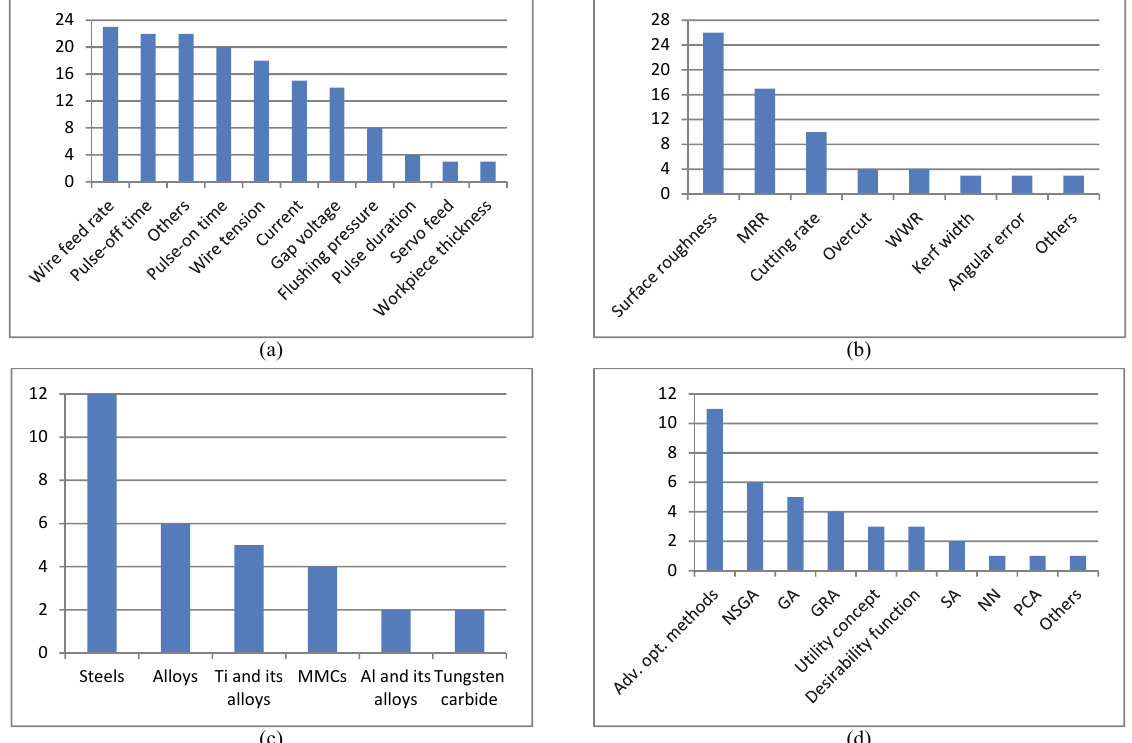
Fig. 3 Analysis on the parametric optimization of WEDM